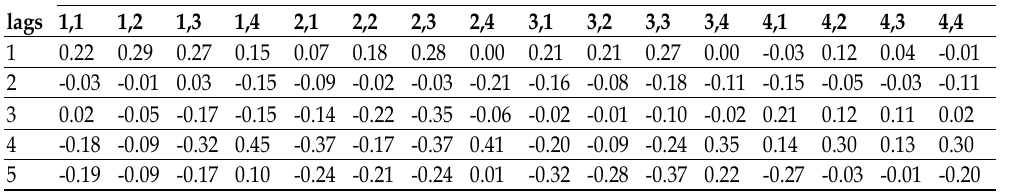
Table 7. Cross Correlation residual Function values (CCF). Railway Infrastructure Capital Stock